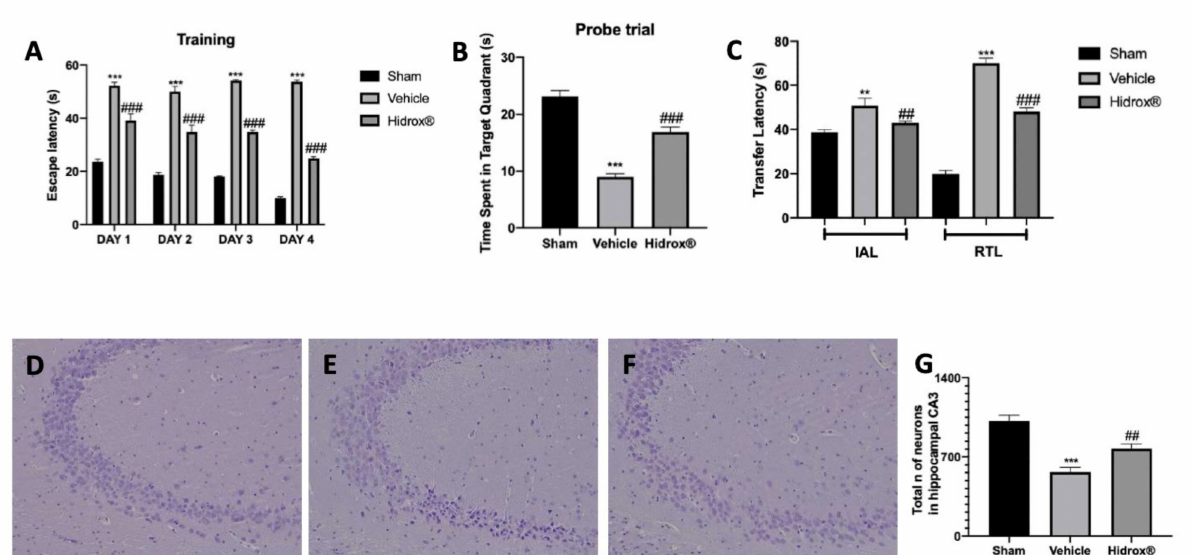
Figure 4. Hidrox ® administration reduced TBI-induced behavioral alterations. Morris Water Maze Test: Training ( A ), Probe Trial ( B ); Elevated Plus Maze Test ( C ), Histological analysis of the hippocampal CA3 area: Sham ( D ), Vehicle ( E ), Hidrox ® ( F ), Total number of neurons ( G ). For the analyses, n = 5 animals in each group were employed. Results were analyzed by two-way ANOVA followed by a Bonferroni post-hoc test for multiple comparisons. Morris Water Maze Test: Training ( A ): F (6,48) = 8.675. The results were analyzed by one-way ANOVA followed by a Bonferroni post-hoc test for multiple comparisons. Probe Trial ( B ): F (2,12) = 71.14; Elevated Plus Maze Test ( C ): F(5,24) = 57.90, Total number of neurons ( G ): F(2,12) = 22.10. A p -value of less than 0.05 was considered significant. ** p < 0.01 vs. sham, ## p < 0.01 vs. vehicle, *** p < 0.001 vs. sham, ### p < 0.001 vs.